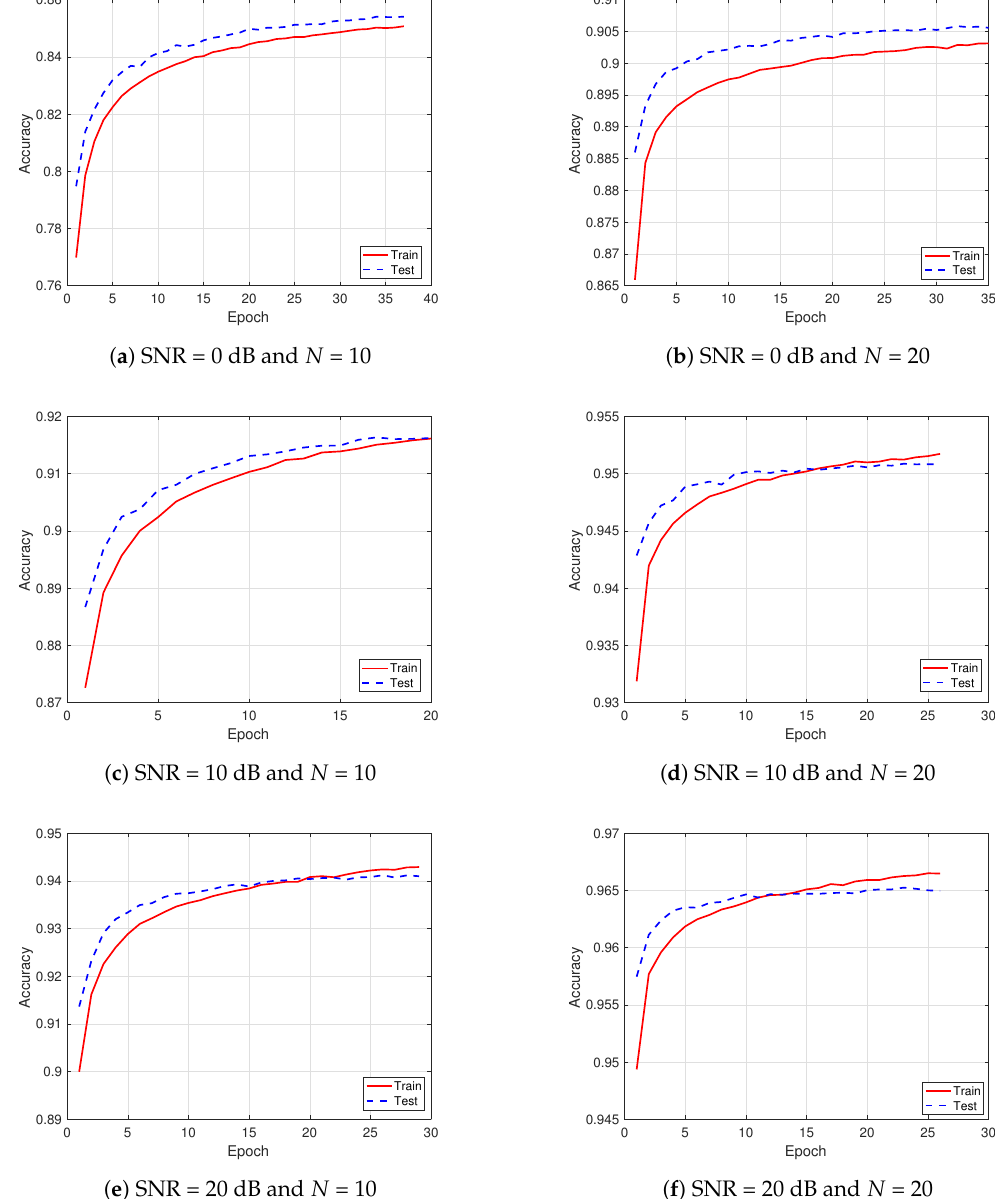
{0 dB, 10 dB, 20 dB} and N = 10 or ∈